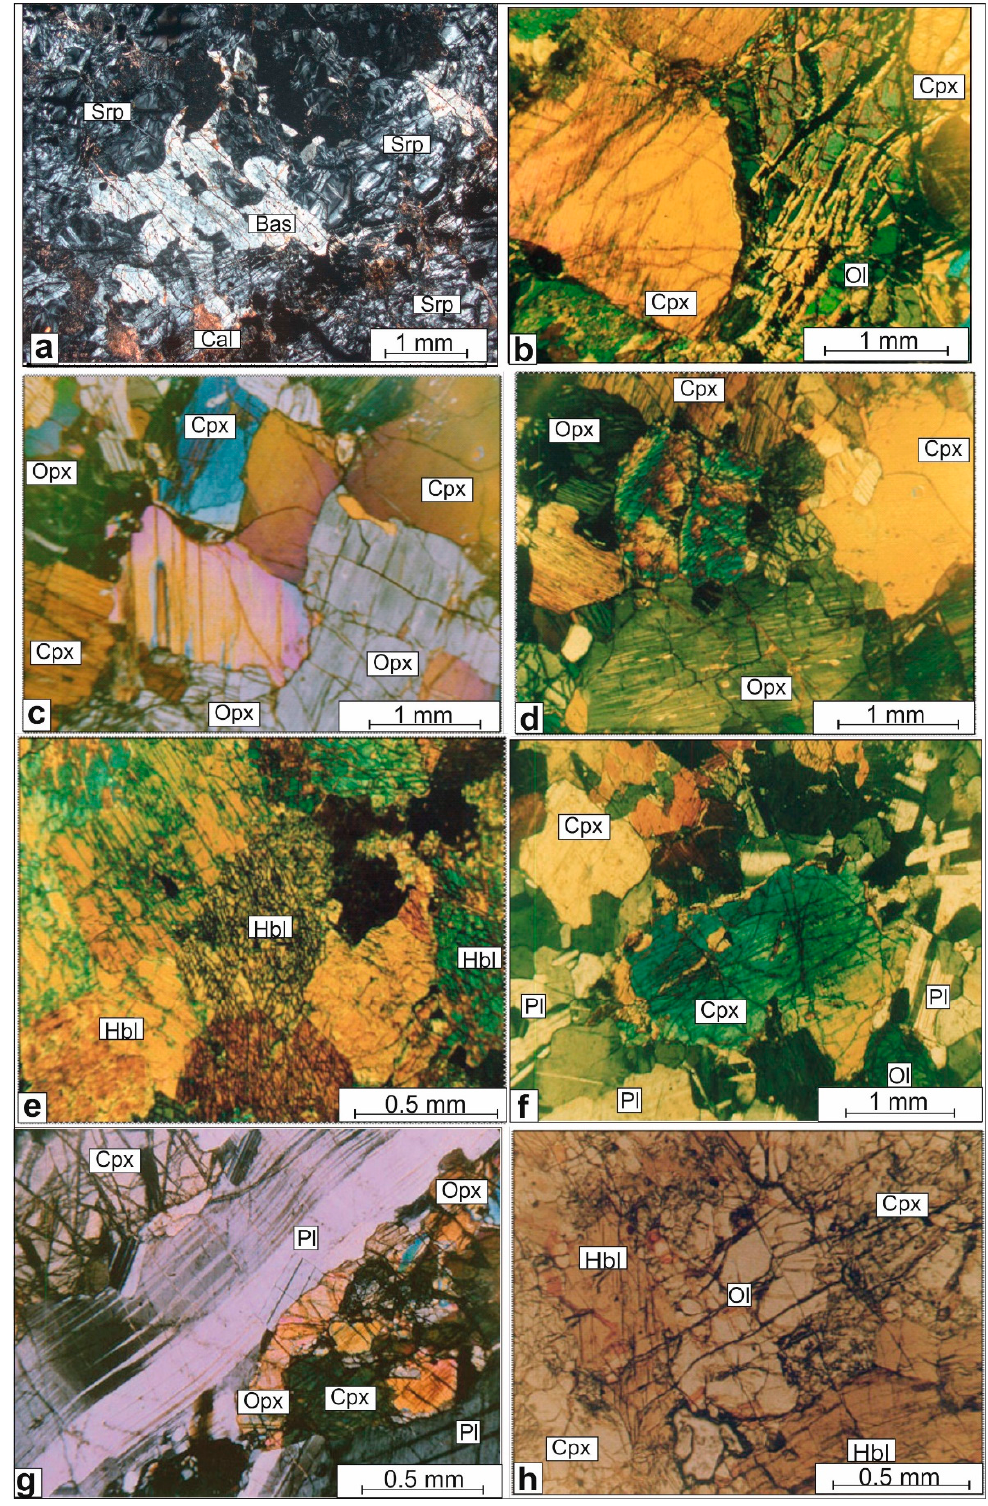
Figure 5. Transmitted-light photomicrographs in plane- and cross-polarized light. ( a ) Serpentinite and bastite (Bas) pseudomorphs after orthopyroxene (sample 3/7). ( b ) Hypidiomorphic wehrlite (sample 3/1). ( c ) Panidiomorphic websterite (sample 4/4). ( d ) Poikilitic websterite (sample 4/2). ( e ) Panidiomorphic hornblendite (sample 8/6). ( f ) Olivine gabbro (sample 3/10) ( g ) Gabbronorite (sample 1/3) that exhibits a trachytic texture. ( h ) Olivine-hornblende clinopyroxenite (sample 7/5). Ol, olivine; Cpx, clinopyroxene; Opx, orthopyroxene; Pl, plagioclase; Hbl, hornblende; Srp, serpentine; Mag, magnetite.